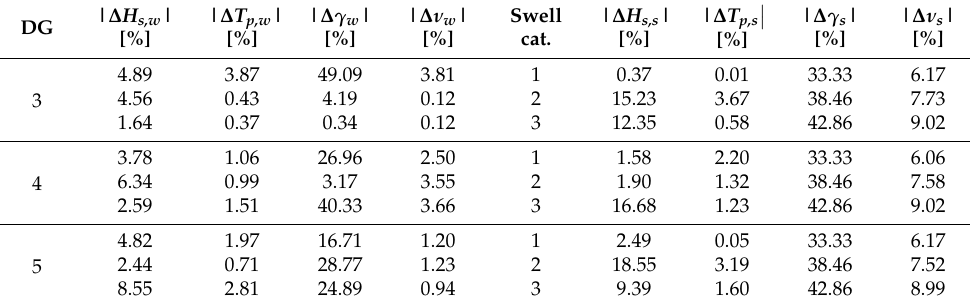
Table 5. Sea state assessment (Thomson)—short duration and low frequency.